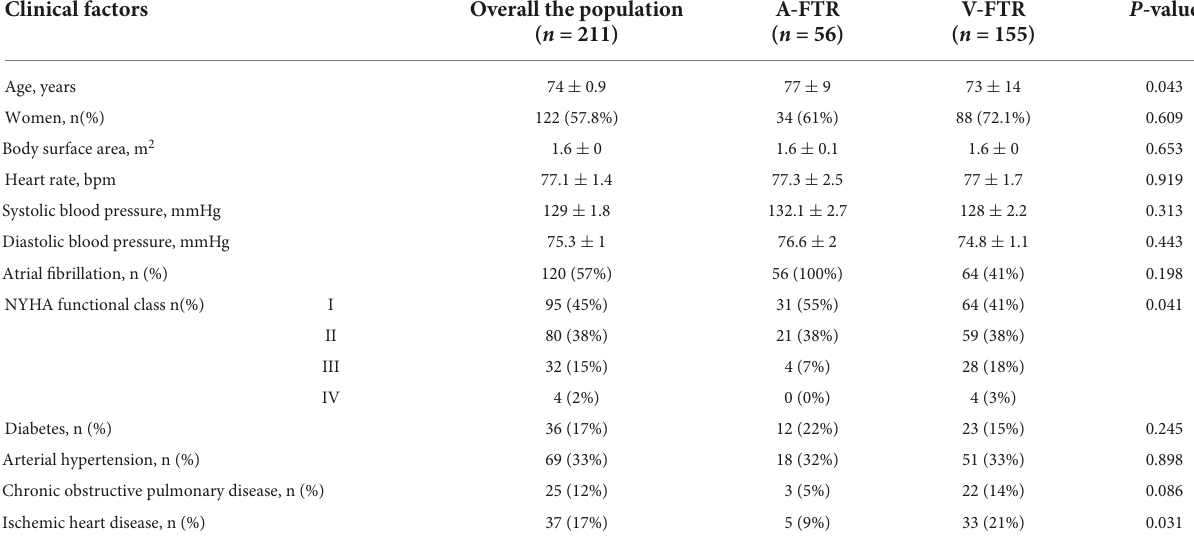
TABLE 1 Clinical characteristics of patients with atrial and ventricular secondary tricuspid